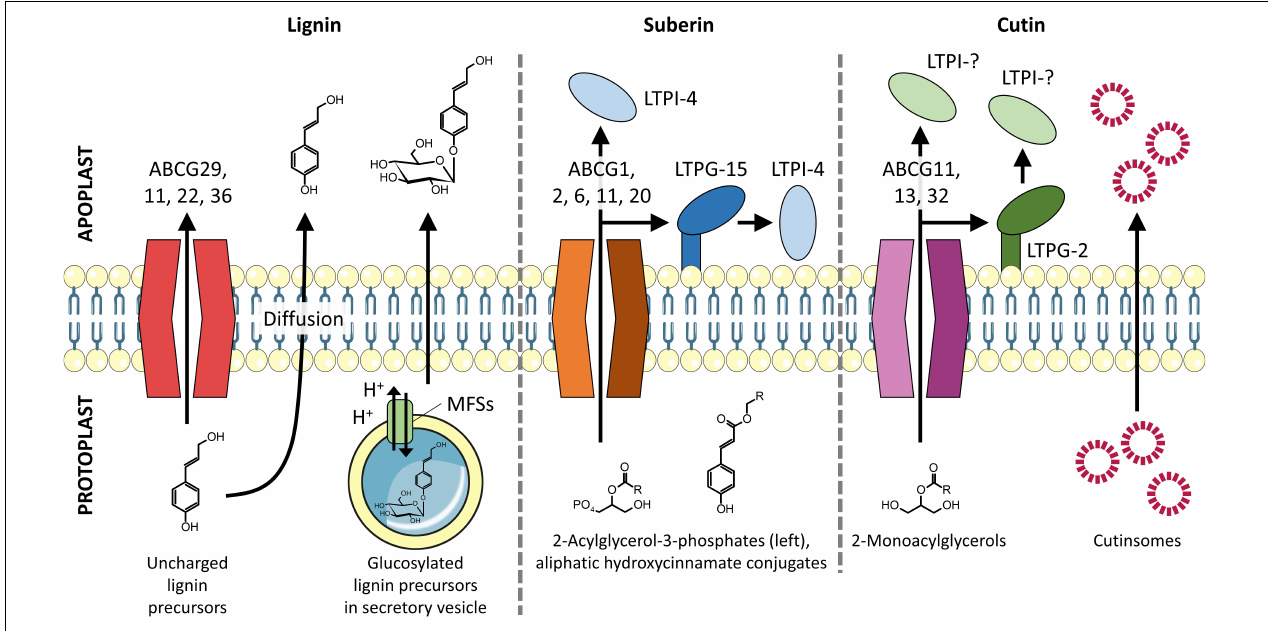
FIGURE 2 | Transmembrane export of lignin, suberin, and cutin precursors into the apoplast. Lignin monomers are proposed to be exported by full-size ABC transporters, vesicle-mediated exocytosis, and passive diffusion. Suberin precursors are found to be exported by half-size ABC transporters with assistance from LTPs. Cutin precursors are exported by both full- and half-size ABC transporters and are proposed to pass through the hydrophilic cell wall by binding to LTPs and/or self-aggregate to form cutinsomes, which have a hydrophilic shell (Domínguez et al.,